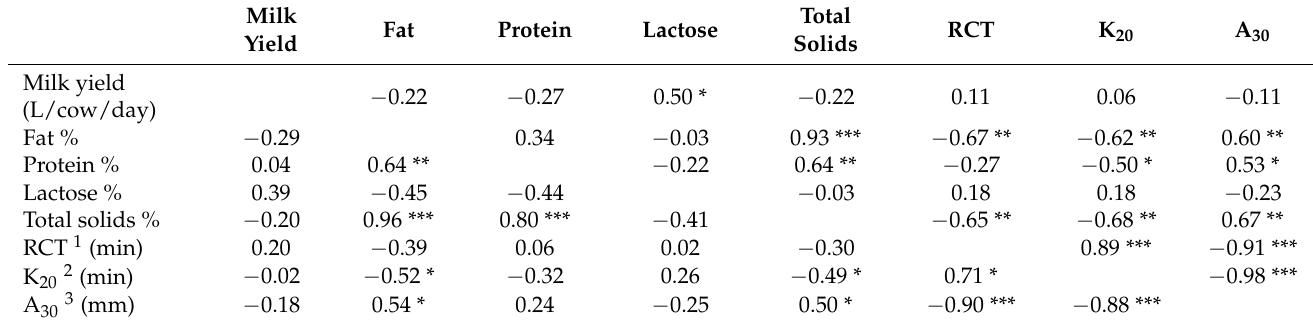
Table 6. Partial correlation coefficients between coagulation properties and milk components of cows milked twice a day (TAD) morning above the diagonal and afternoon below the diagonal during the late lactation in the 2020–2021 production